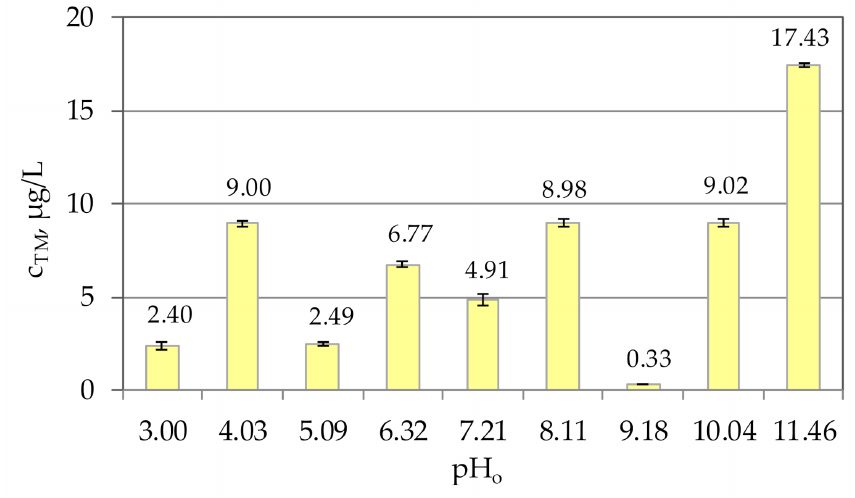
Figure 6. The concentration (mean ± SD) of total mercury leached in ultrapure water of different pH o values in the range 3.00–11.46 after 24